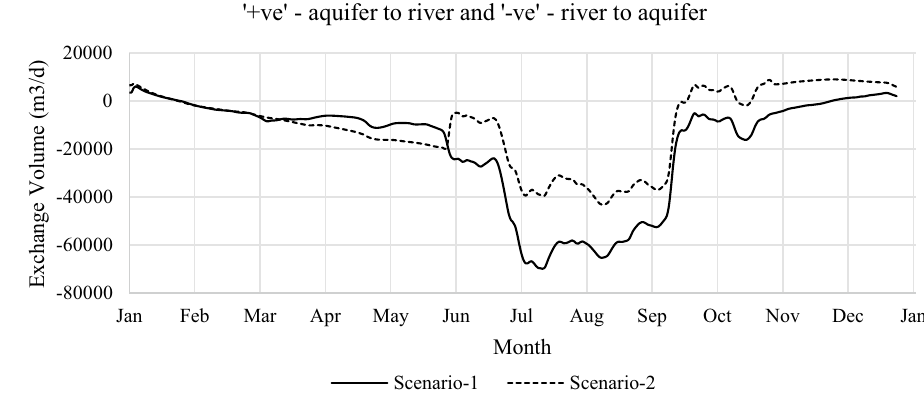
Fig. 14 Comparison of river– aquifer interaction between sce- nario-1 and scenario-2 in 2029. Negative exchange volume indi- cates a flow from the river to the aquifer, while positive exchange volume indicates a flow from the aquifer to the river. Results indicate that aquifer discharges more to the river in scenario-2, where river discharges more to the aquifer in